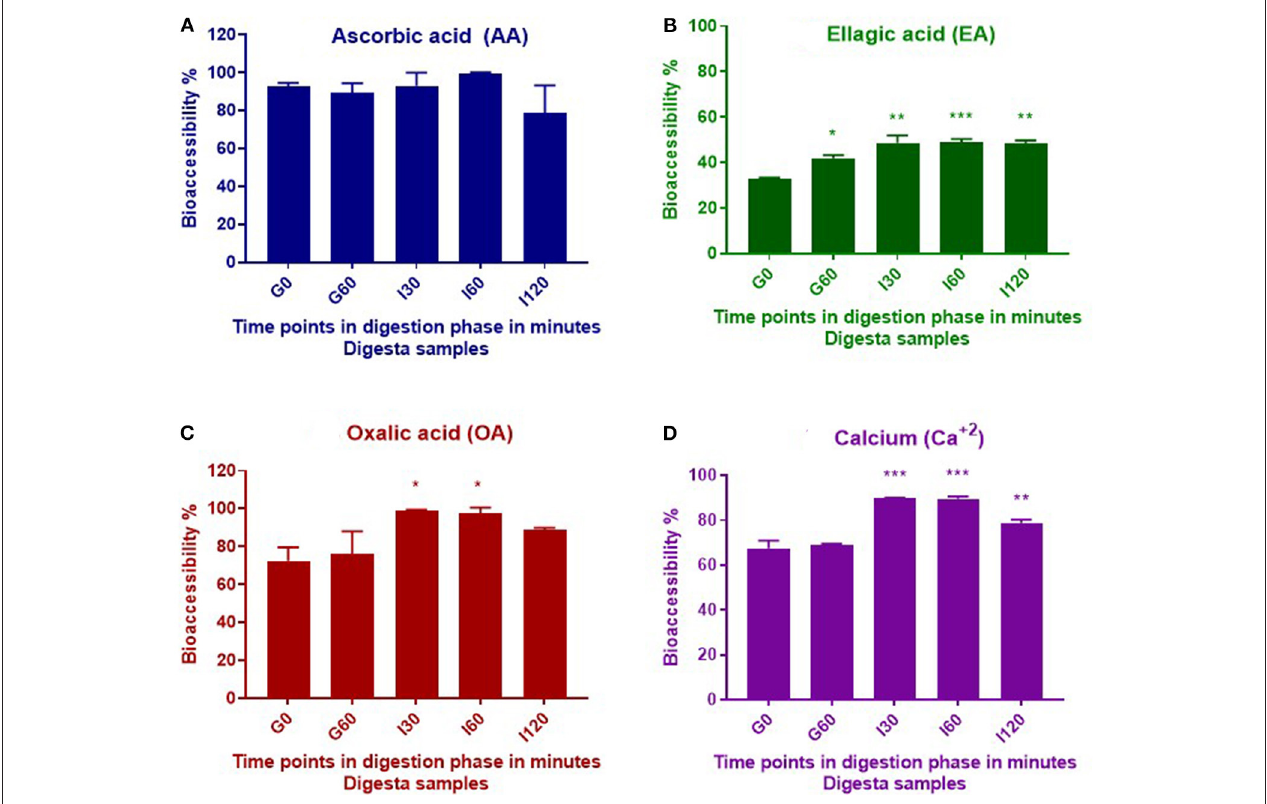
FIGURE 2 | Bioaccessibility of AA (A) , EA (B) , OA (C) , and calcium (D) during in vitro digestion of T. ferdinandiana freeze-dried powder. Asterisks (*) indicate differences that are statistically significant between gastric t = 0 (G0) digesta and digesta from other stages of digestion (* p ≤ 0.01, ** p ≤ 0.001, *** p ≤ 0.0001). G0, gastric 0min; G60, gastric 60min; I30, intestinal 30min; I60, intestinal 60min; and I120, intestinal 120min.